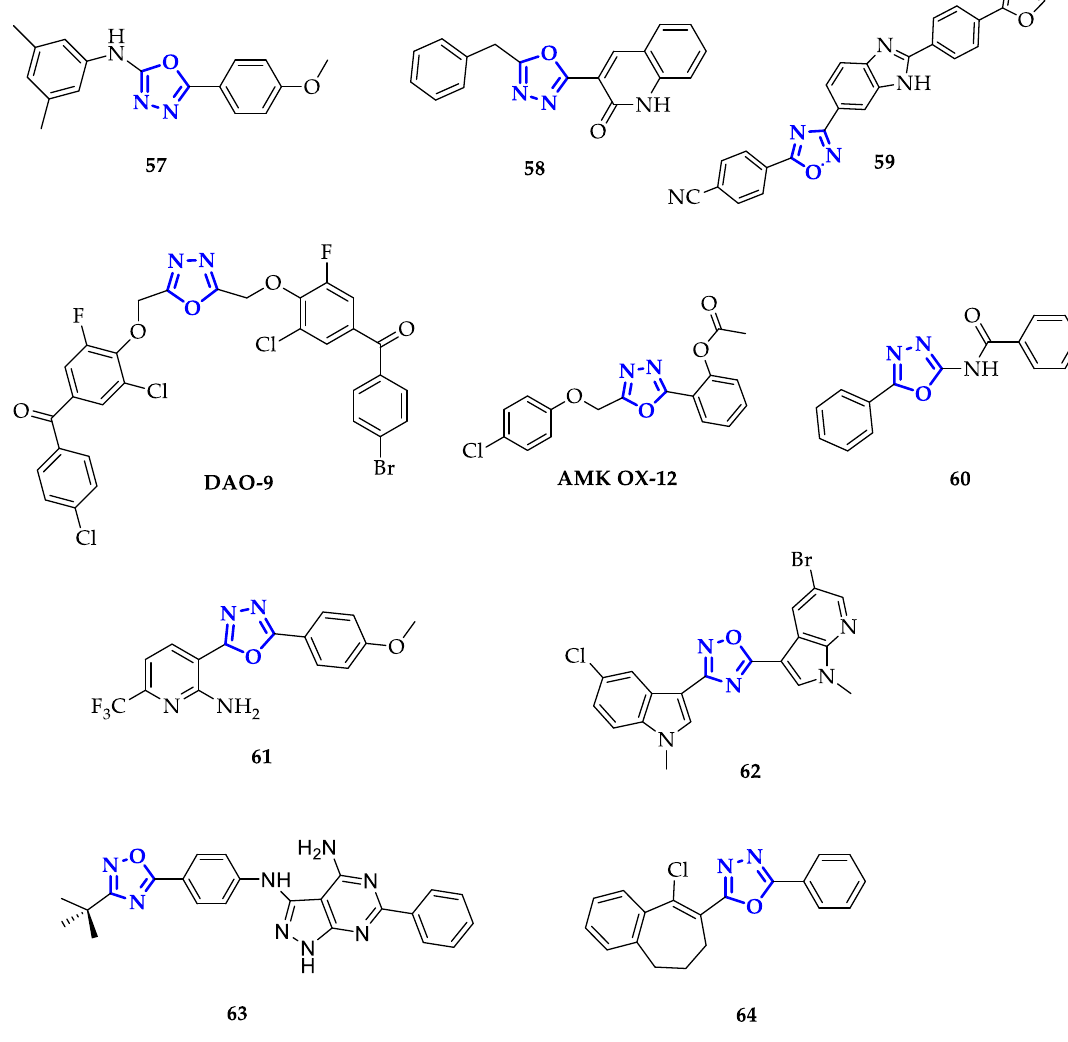
Figure 11. Oxadiazoles with extended aromatic system.